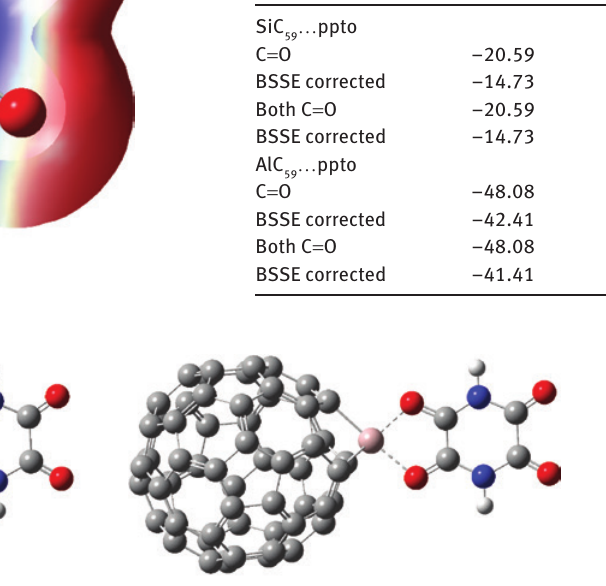
Figure 2: Optimized structure of the investigated